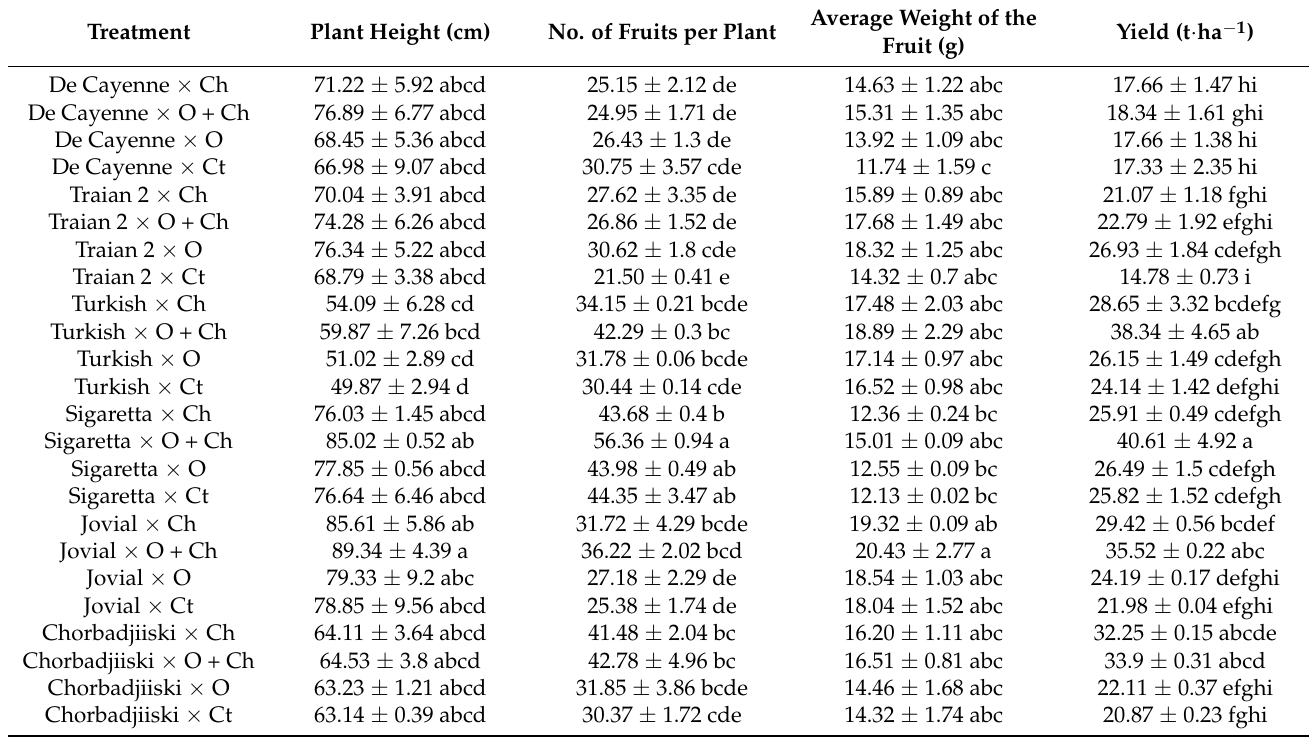
Table 3. Biometric parameters and yield of chili peppers under interaction of cultivar and